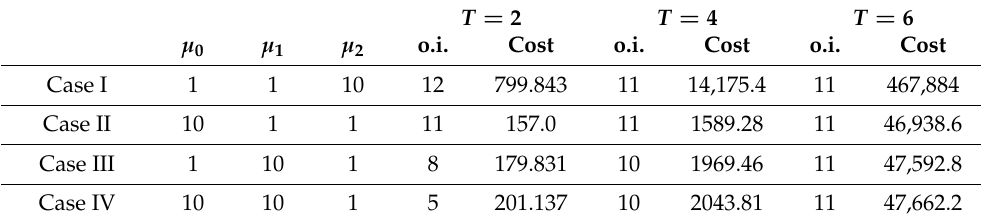
Table 4. Number of outer iterations (o.i.) and cost for three final times T and four cases.